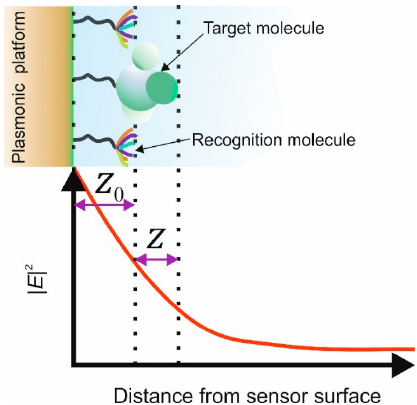
Figure 3. Conceptual representation of the dependence of the surface plasmon electric field on the distance from the metal surface of the sensor.